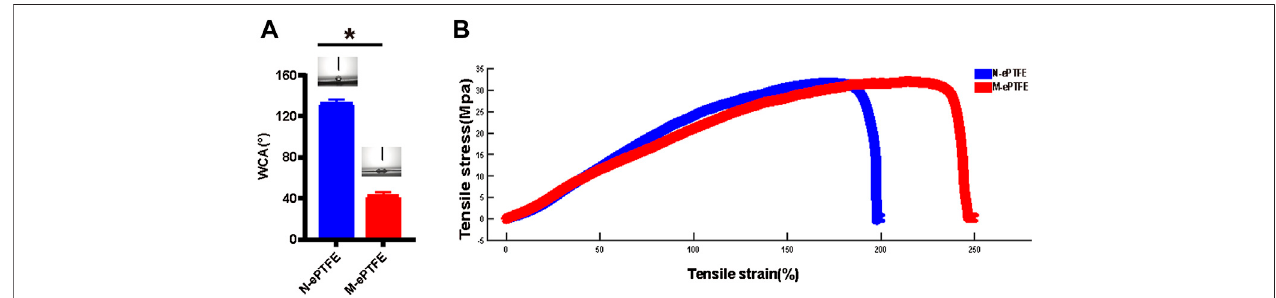
FIGURE3| Differencesin (A) watercontactangle(WCA)and (B) tensilepropertiesbetweenunmodi fi edN-ePTFE/M-ePTFE,expandedpolytetra fl uoroethyleneand modi fi ed ePTFE (M-ePTFE).